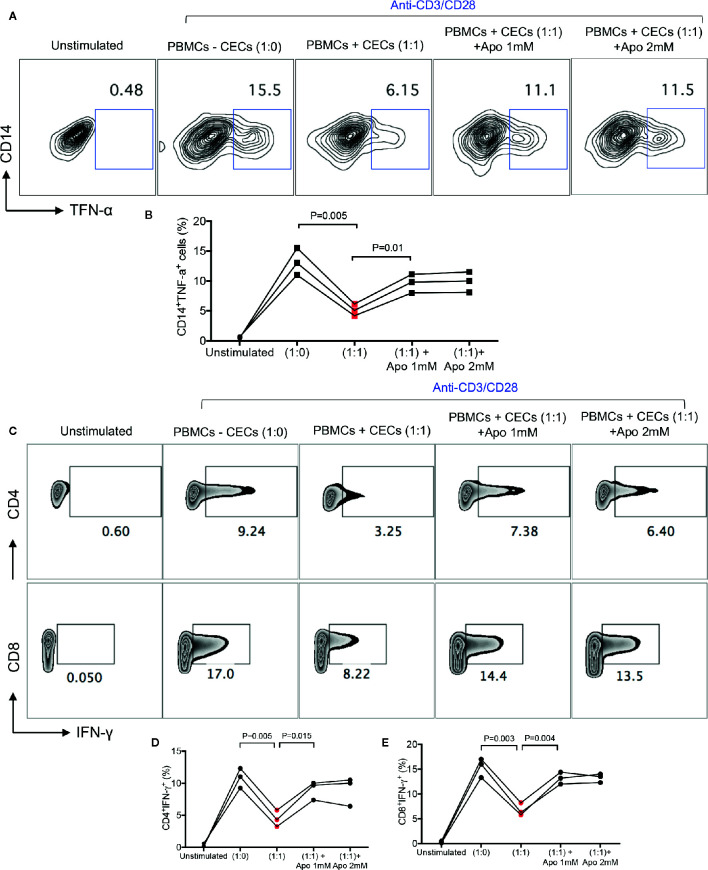
CECs from human infants exhibit immunosuppressive properties in vitro. (A) Representative plots, and (B) cumulative data showing TNF-α production by CD14+ cells following stimulation with LPS (2 μg/ml) in the absence/presence of CECs (1:1) ratio and presence of apocynin at shown concentrations for 6 h with a Golgi blocker. Samples are from three infants aged 2–4 weeks. (C) Representative plots, and (D) cumulative data showing IFN-γ production by CD4+ or (E) CD8+ T cells following stimulation with anti-CD3/CD28 in the absence/presence of CECs (1:1) ratio and presence of apocynin at shown concentrations for 18 h with an additional 6 h in the presence of a Golgi blocker. Samples are from three infants age 2 to 4 weeks.